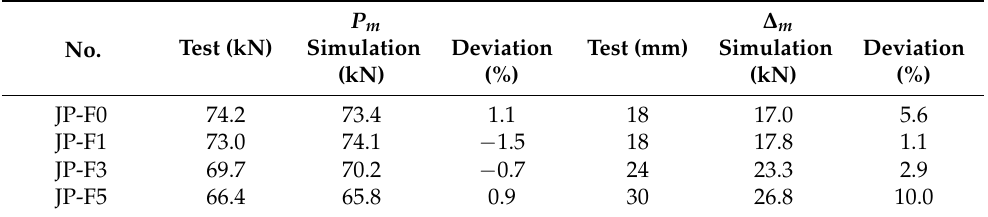
Table 5. Peak load and peak